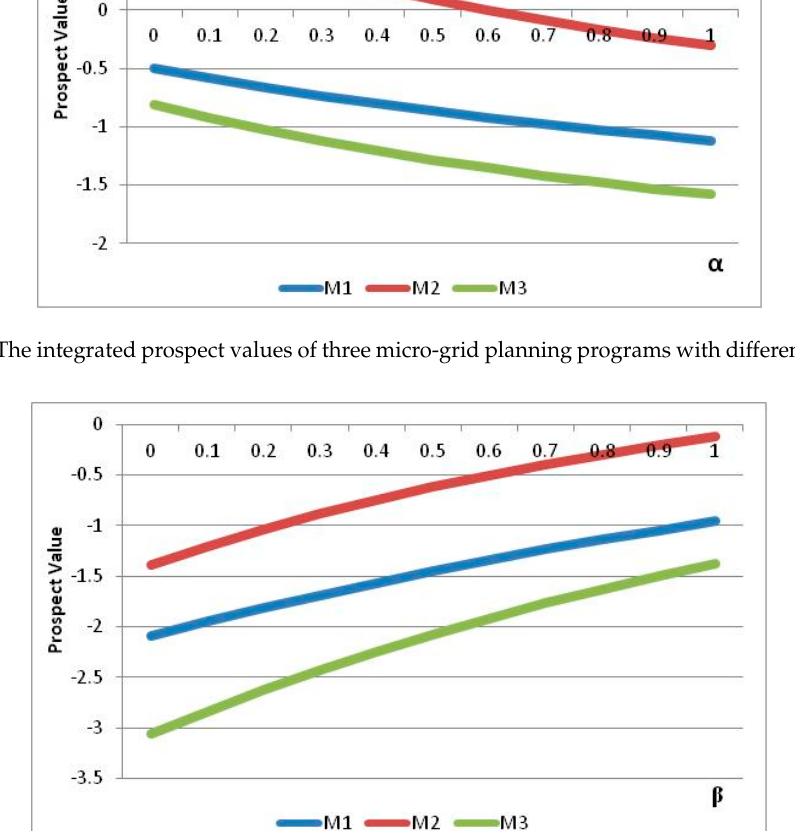
Figure 5. The integrated prospect values of three micro-grid planning programs with different β values.